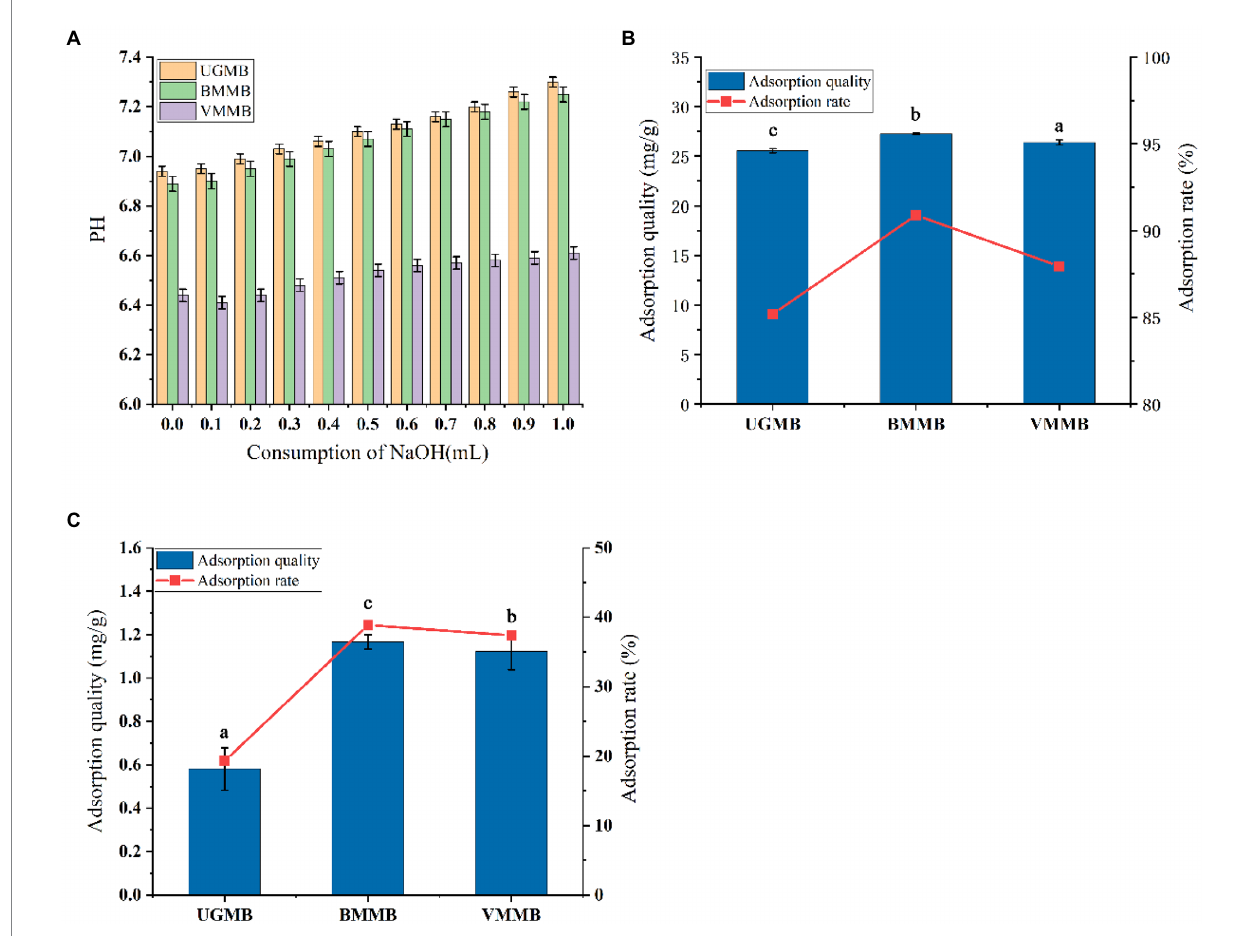
FIGURE 7 Functional characteristics of Mung bean powder: (A) is the cation exchange capacity, (B) is the adsorption capacity of cholate, and (C) is the adsorption capacity of tobacco